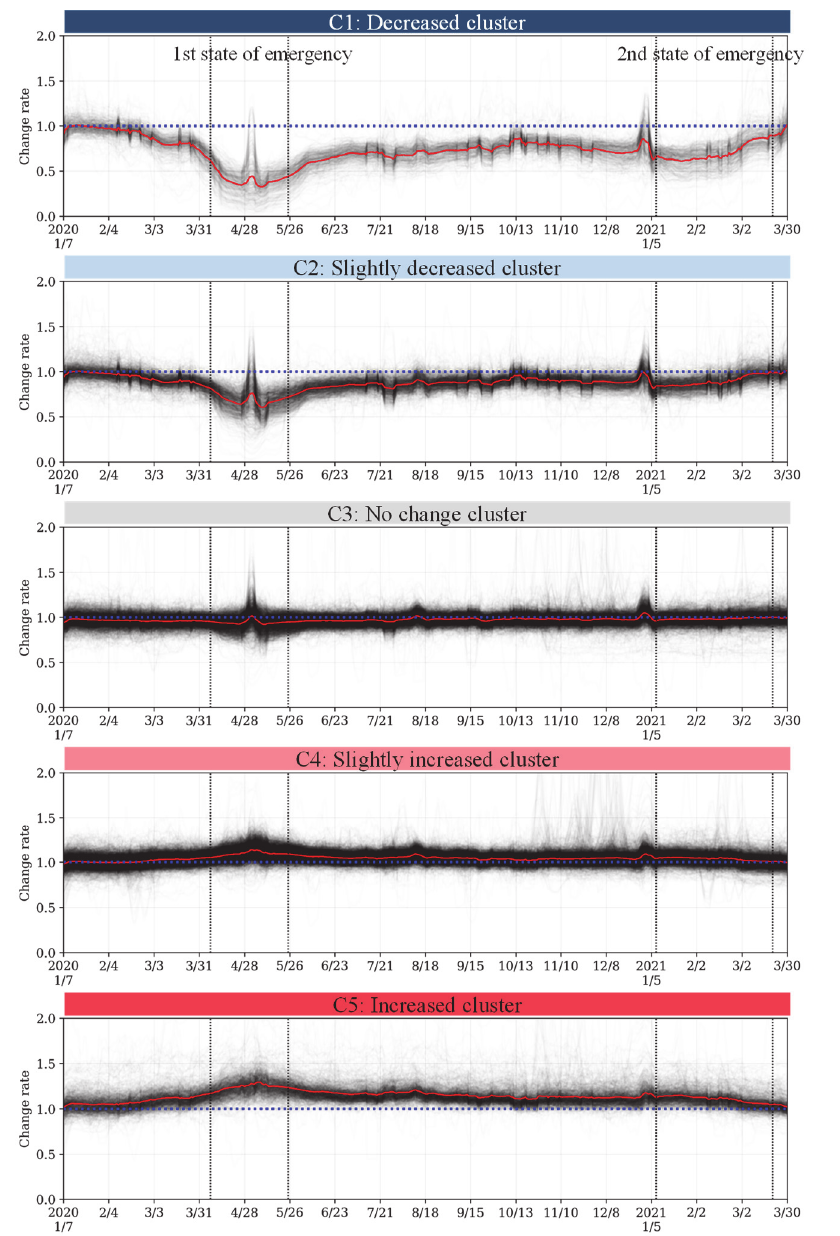
Figure 6 . Human mobility change patterns in commercial